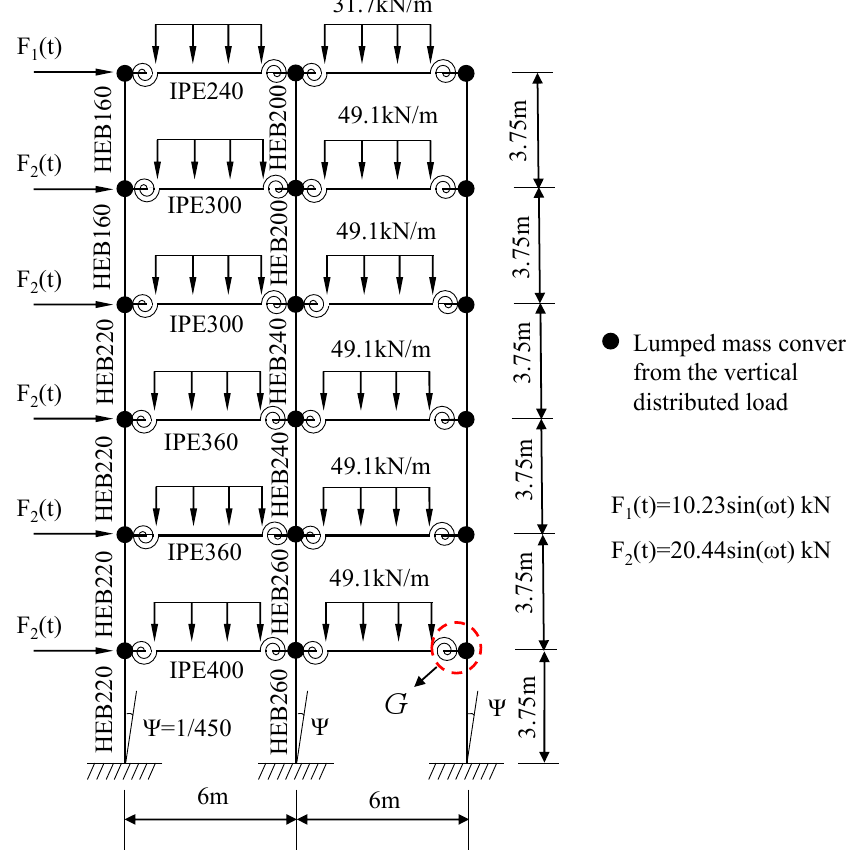
Figure 21. Configuration and loading of the two-span, six-story Vogel steel frame.